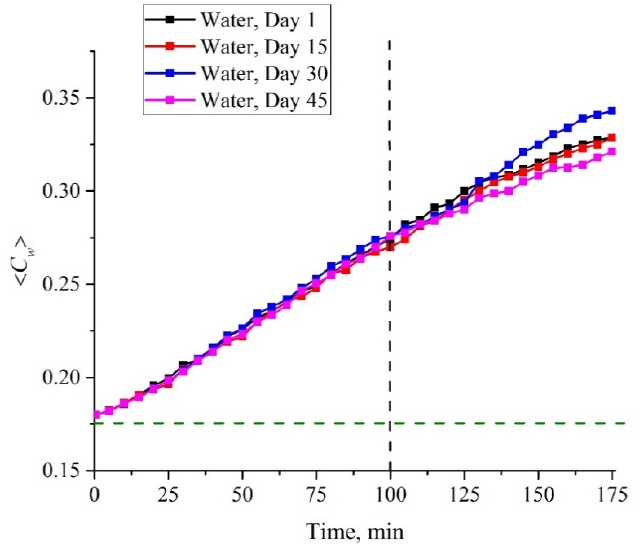
Figure 6. Dependences of the average water content C w ( t ) ; measurements were taken on different days at intervals of 15 days and samples were taken on different Milli-Q devices.